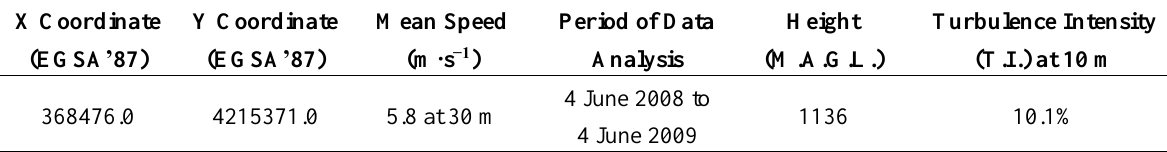
Table 1. Main measured characteristics of the wind